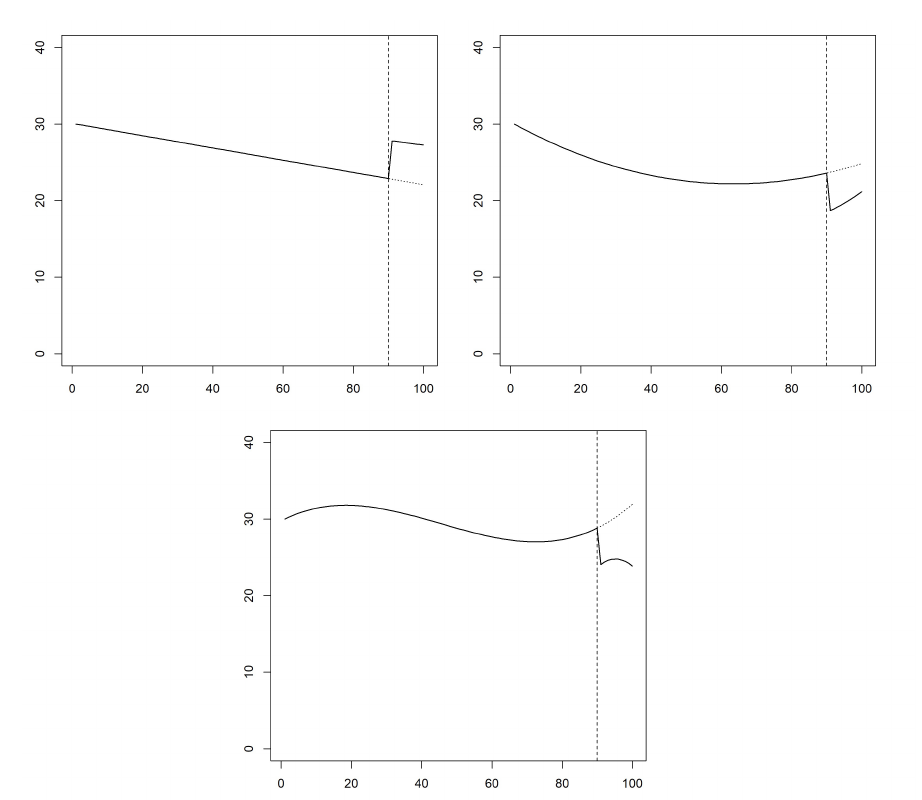
Figure 1. Simulated data. The left upper plot shows the linear model, the right upper plot shows the quadratic model and the lower plot shows the polynomial model. In all pictures, the black line refers to the deterministic part of the simulated data, and the dashed line refers to the projection of the pre-intervention model in the post-intervention